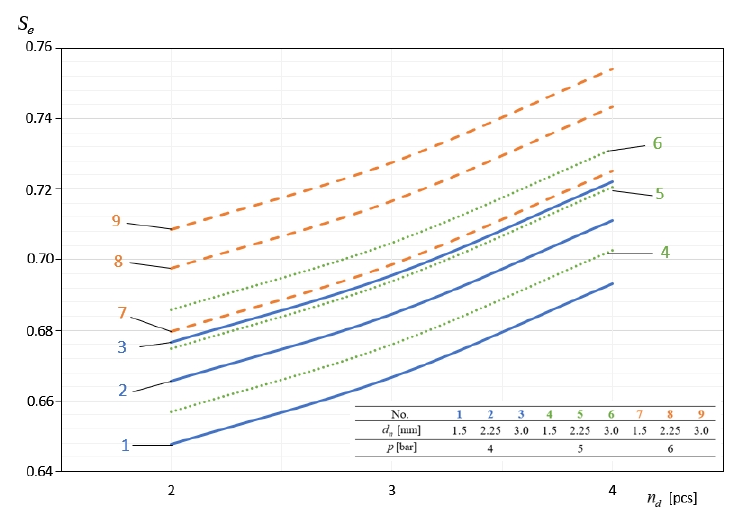
Figure 11. The influence of the number of nozzles removing the incised material (scale) on shaping the efficiency of the machine’s operation at constant parameters h d = 40 mm and v p = 60 pcs./min.